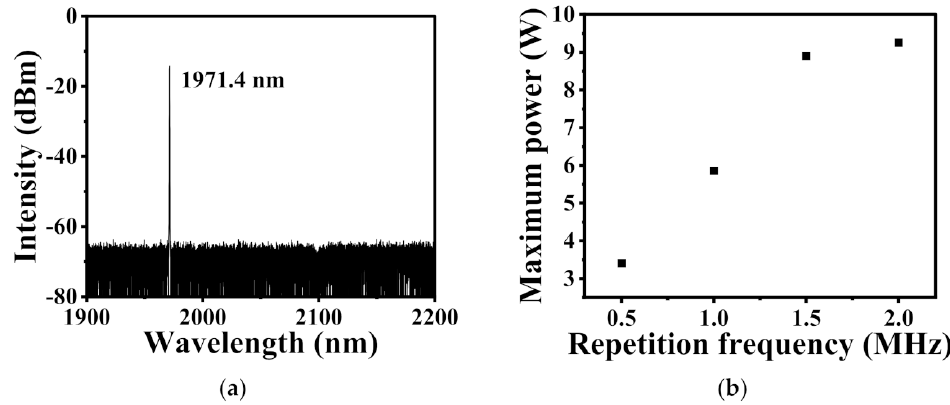
Figure 2. ( a ) The spectrum of the seed laser; ( b ) the maximum output power of the TDFA at different repetition